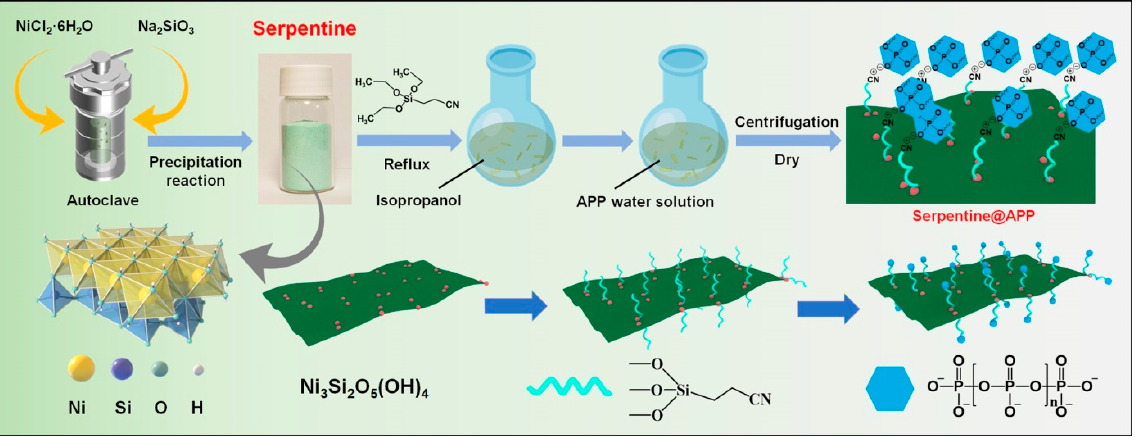
Table 1. Formulations of pure PLA and its